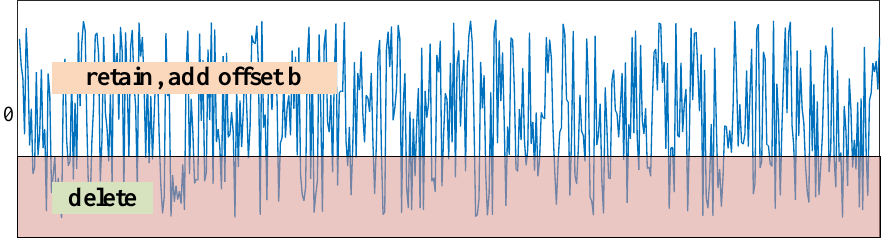
Figure 12. ReLU function when 𝑏 > 0 .